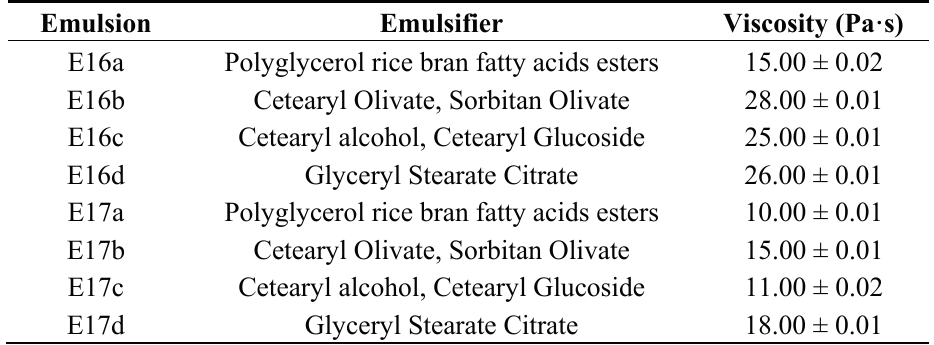
Table 8. Viscosity values of emulsions containing UV